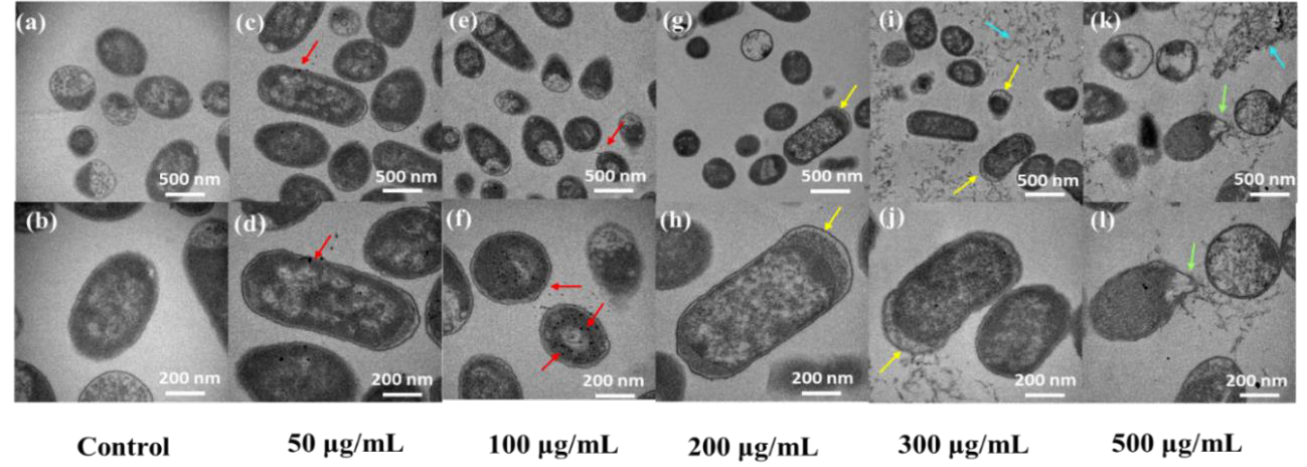
Figure 8. Ultrathin images of E. coli using a biological transmission electron microscope. ( a , b ) Blank group, ( c , d ) 50 μg/mL, ( e , f ) 100 μg/mL, ( g , h ) 200 μg/mL, ( i , j ) 300 μg/mL, and ( k , l ) 500 μg/mL.